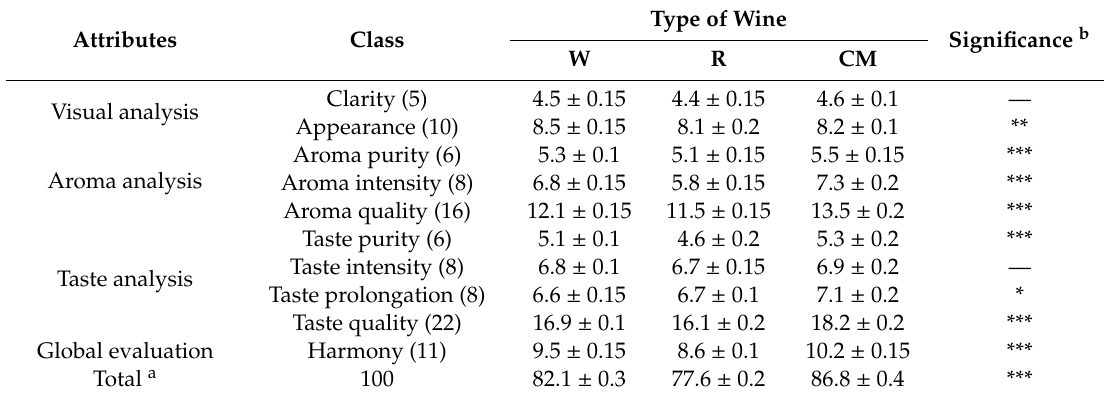
Table 4. Sensory analysis of Muscat Hamburg wines produced by di ff erent winemaking